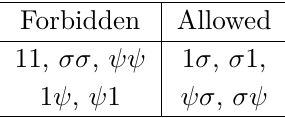
Table 7 . The forbidden and allowed configurations in the Ising